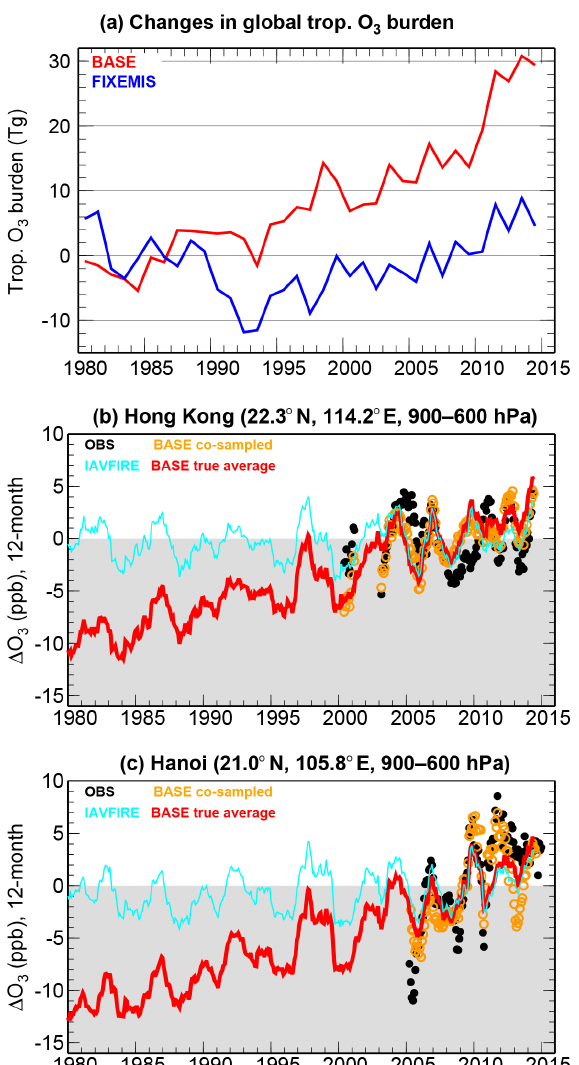
Figure 5. (a) Time series of changes in global tropospheric O 3 bur- den relative to the 1981–1990 mean from BASE and FIXEMIS simulations (Table 1). (b) Time series of 12-month running mean anomalies (relative to the 2005–2014 mean) of O 3 averaged over 900–600hPa at Hong Kong from the averages of ozonesonde sam- ples (black circles) and the BASE model co-sampled on sonde launch days (orange circles) versus the true average from BASE and IAVFIRE with continuous daily sampling (solid lines). (c) Same as (b) , but for Hanoi.